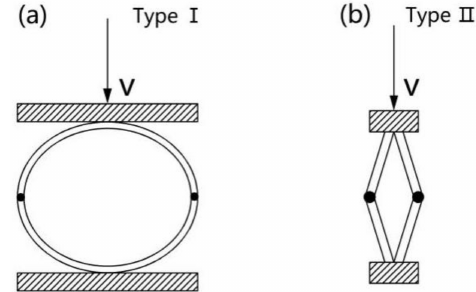
Figure 6. Two simple types of energy-absorbing